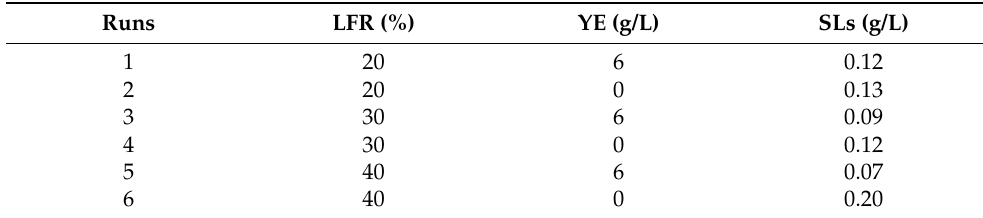
Table 2. LFR and yeast extract concentration evaluated on biomass and antibacterial sophorolipids production by marine R. rubra .